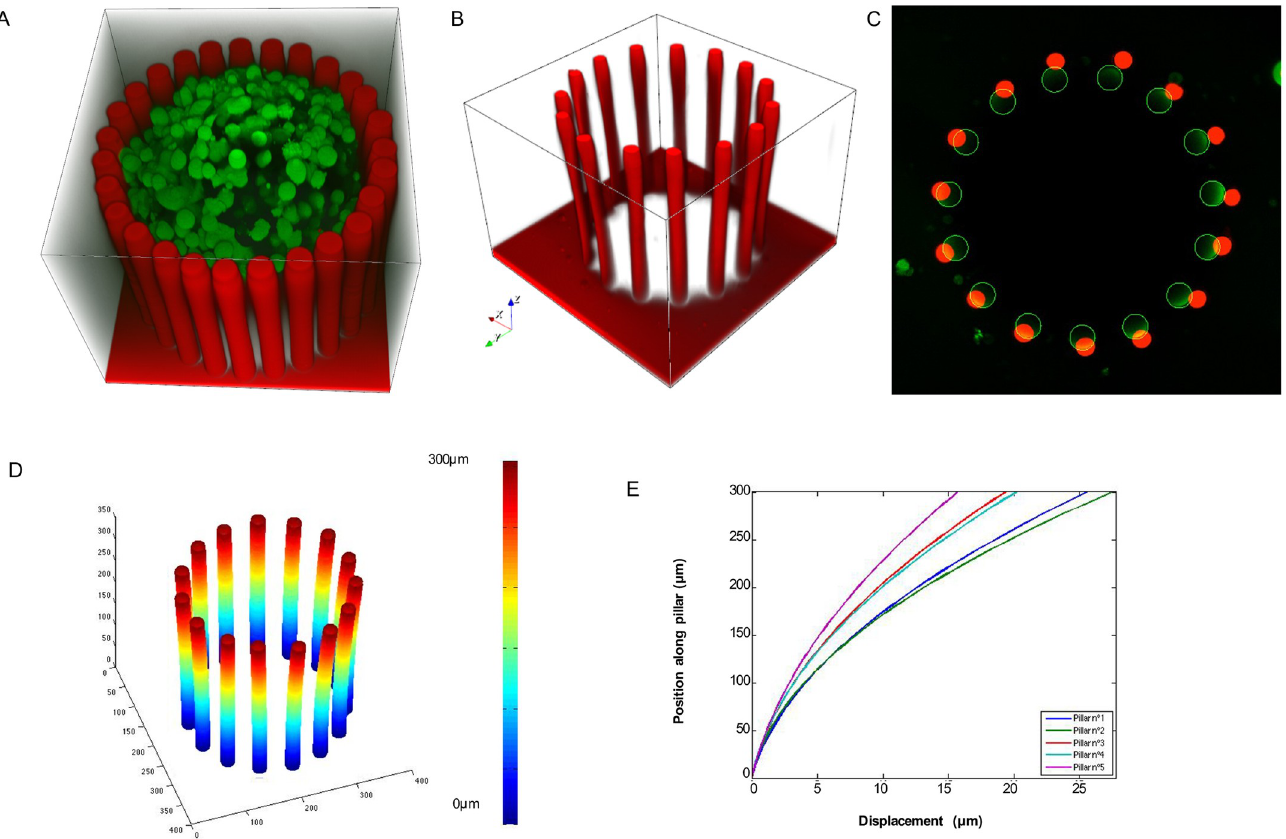
Fig 2. 3D reconstruction of pillar deformations. (A) 3D confocal image showing a microdevice stained with Dil (red; fluorescent lipophilic tracer) surrounding an MCF-7 (mammary cancer cell line)-derived spheroid stained with the fluorescent dye CMFDA-SE (green). (B) 3D visualization of the z-stack images (step size = 4 μ m) of the microdevice where pillar deflection induced by the spheroid growth (unlabelled spheroid) is clearly visible. (C) Superimposition of the first (base) and last (top) images of the z-stack showing the pillar radial displacement; green, bottom, and red, top of each micropillar. (D) 3D reconstruction of the detected centres of all pillars in each image of the z-stack (75 images). (E) Deformation curves of five pillars showing the deflection magnitude along the pillar length (300 μ